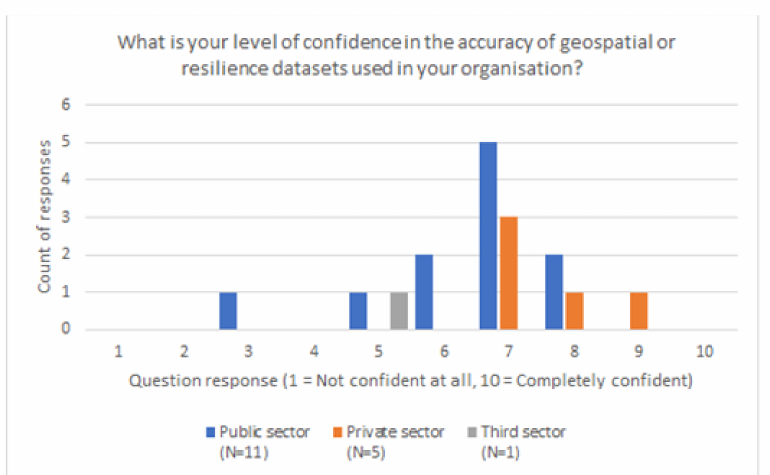
Figure 3. Number of responses per sector obtained for the following survey question: “What is your level of confidence in the accuracy of geospatial or resilience datasets used in your organisation?”. Participants from the public and third sectors emphasised incomplete or poor-quality data sets (Figure 4). Incomplete data sets included property data, insurance loss data and key areas such as utilities. Participants highlighted concerns around the accuracy of modelled flood warnings. Restrictions on sensitive data increased the impact of incomplete data sets.